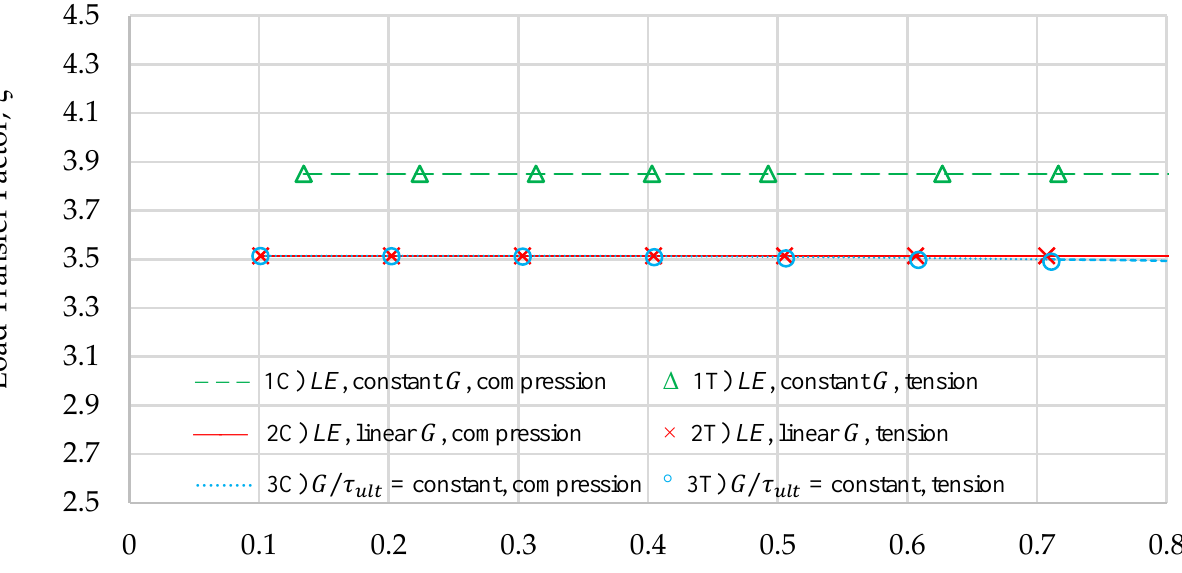
Figure 5. Load transfer factor versus stress ratio at mid-depth for Models 1 to 3.